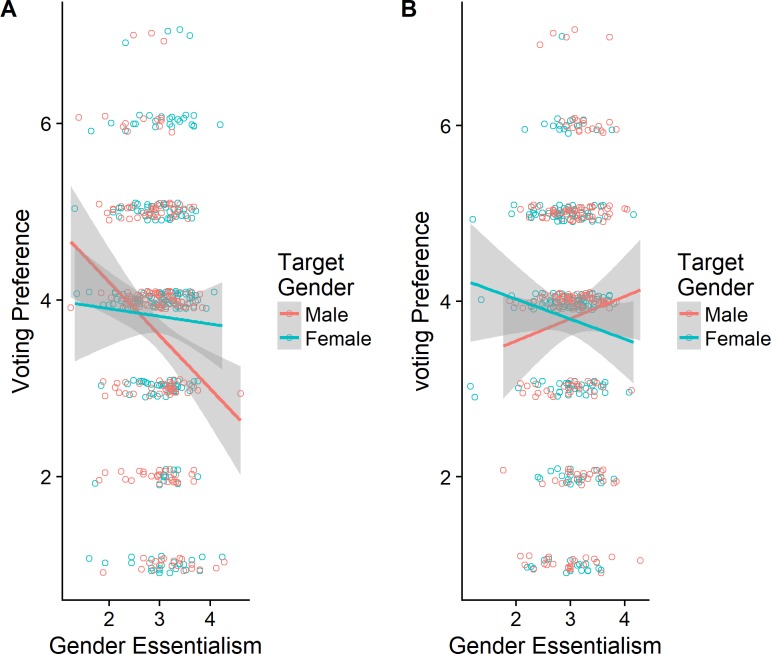
The effects of gender essentialism and target gender on voting preferences.The figure represents the data points with .1 jitter added to avoid overplotting, the fitted linear trend for each condition, and 95% confidence intervals.